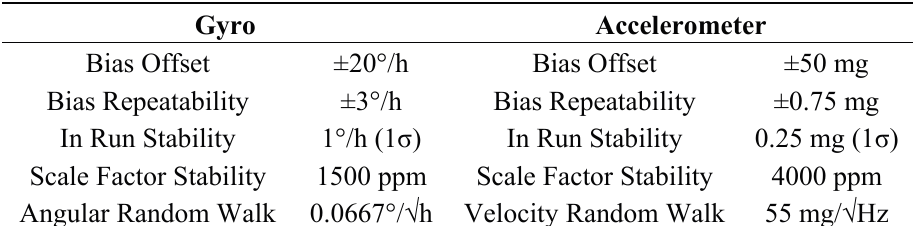
Table 1. IMU sensor specifications.